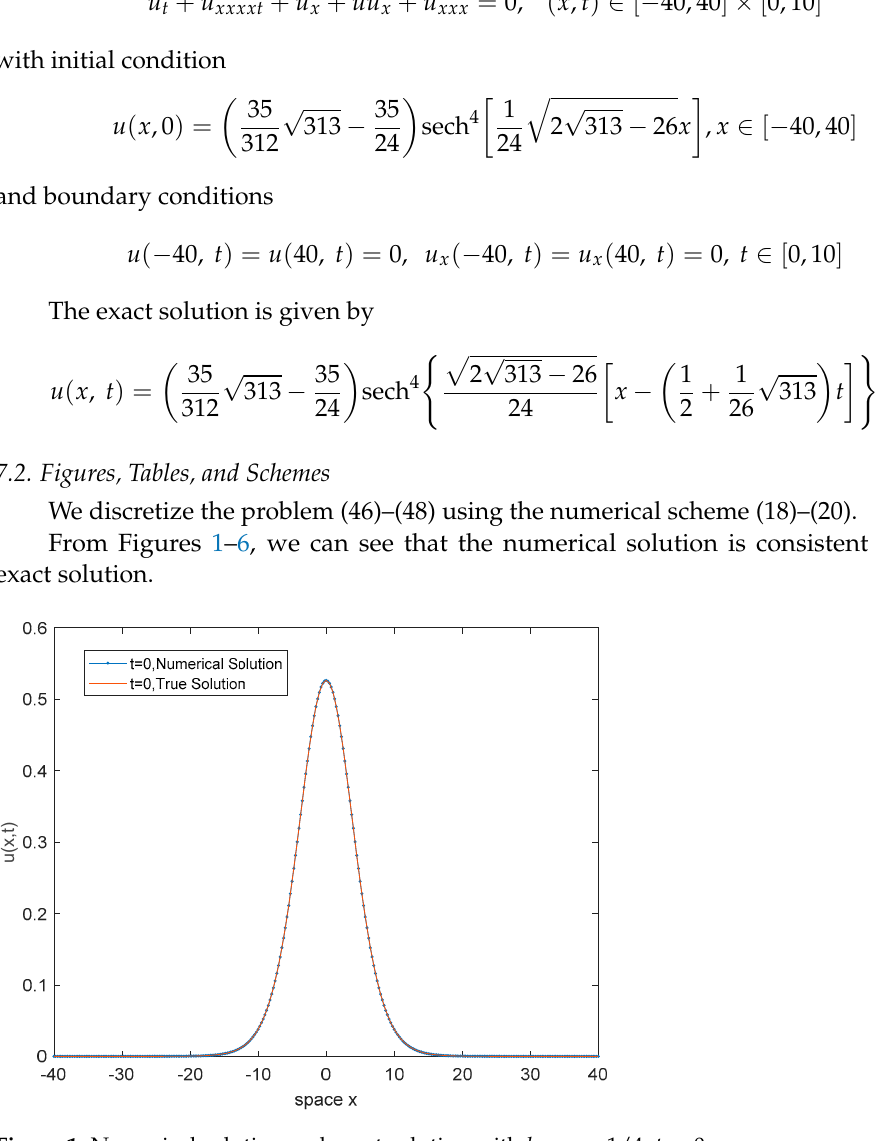
Figure 2. Numerical solution and exact solution with